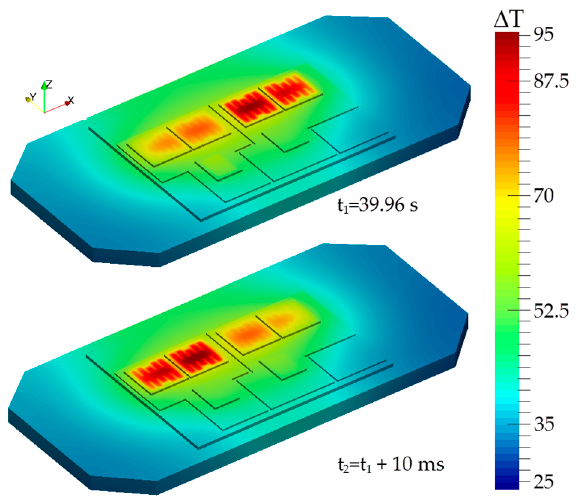
Figure 10. Two temperature maps at the time instants t 1 = 39.96 s and t 2 = t 1 + 10 ms of the module mounted on a 0.2 K/W heatsink.